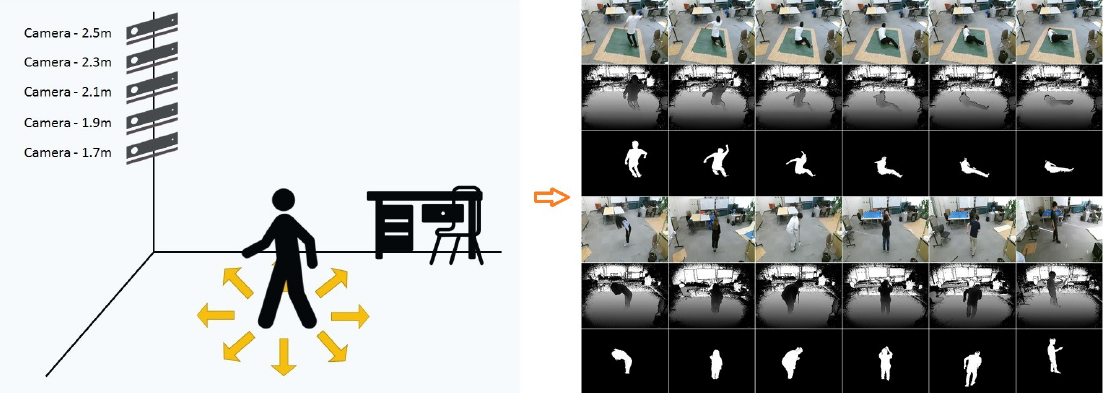
Figure 1. Diagram of our data